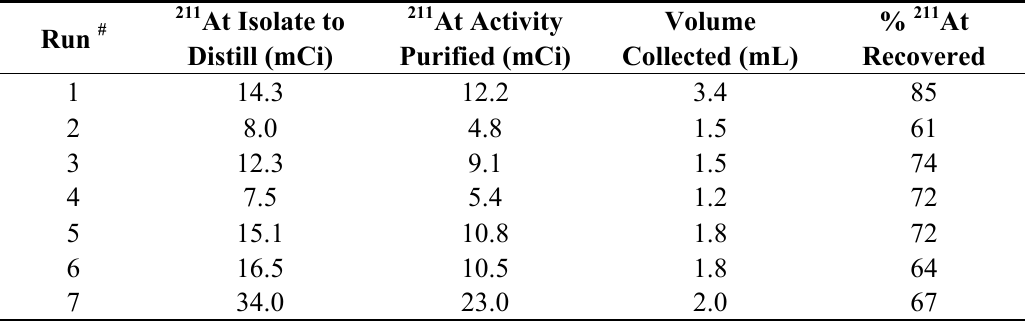
Table 2. Isolation yields after reductive